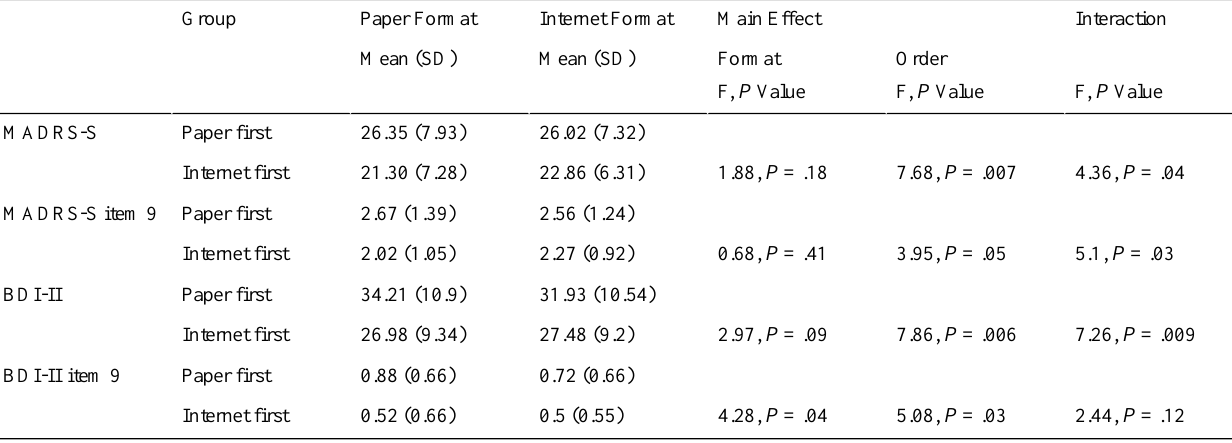
Table 4. Means (SD), main effects, and interaction effect